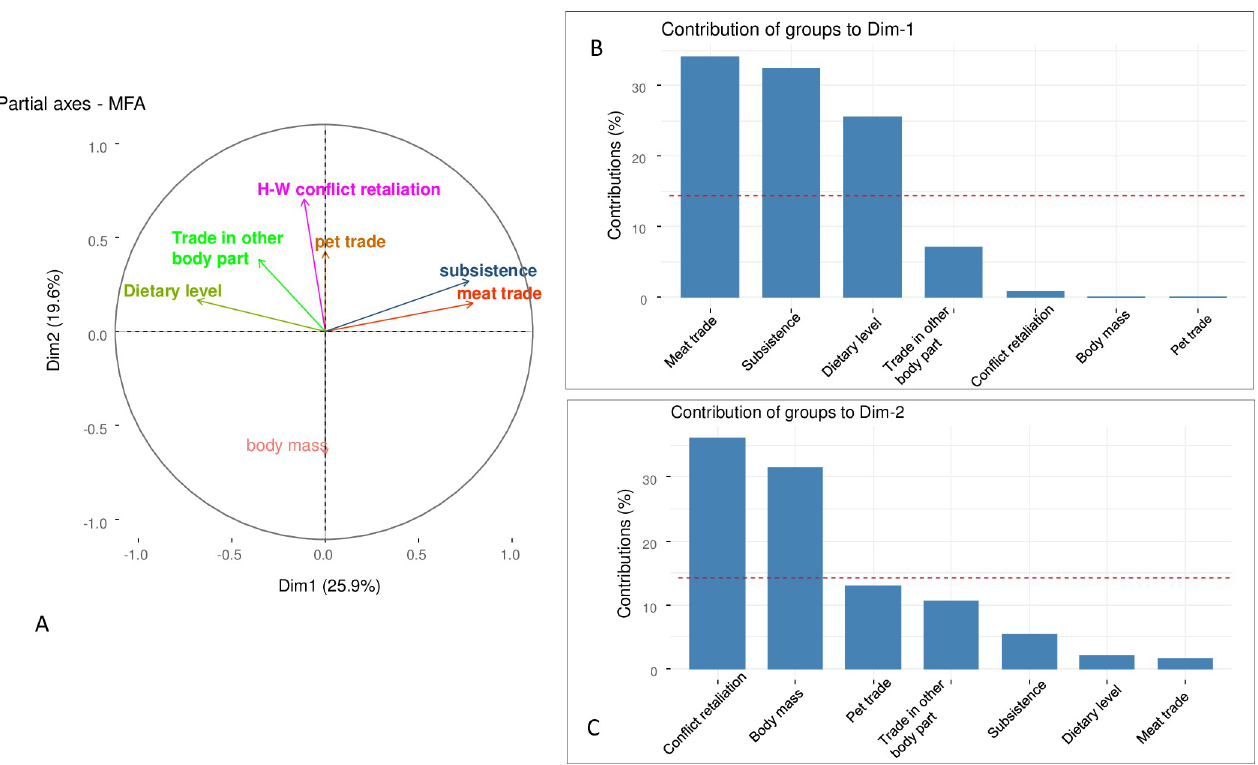
Fig 3. Species compositional similarity in terms of hunting motivations obtained from (a) a multiple factor analysis (MFA). Contributions of each hunting motivation and species trait for (b) the first (Dim 1 ) and (c) the second dimension (Dim 2 ). The red dotted line indicates the percentage that would be obtained if all factors contributed equally to the overall